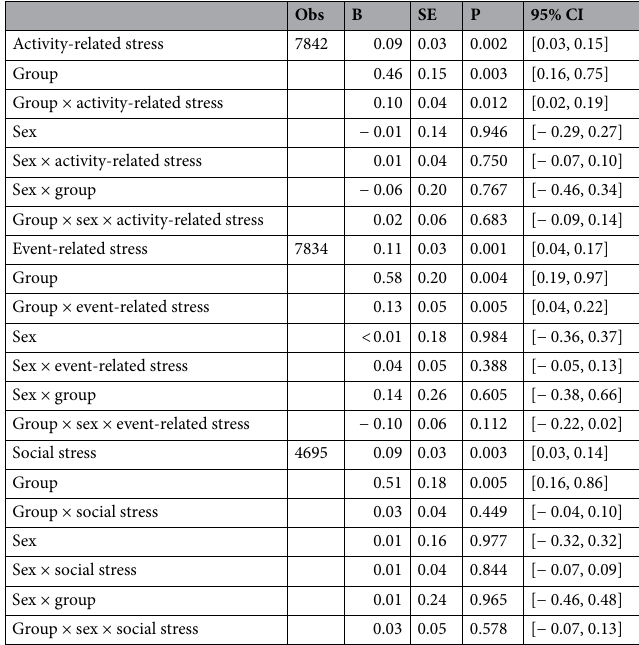
Table 2. Multilevel regressions estimate of stress, group, sex, and their interactions in the model of negative affect. Obs, number of observations; B, standardized regression coefficient; SE, standard error; CI 95%, 95% confidence interval. The dependent variable in all models is negative affect. All models control for age and lifetime depression.